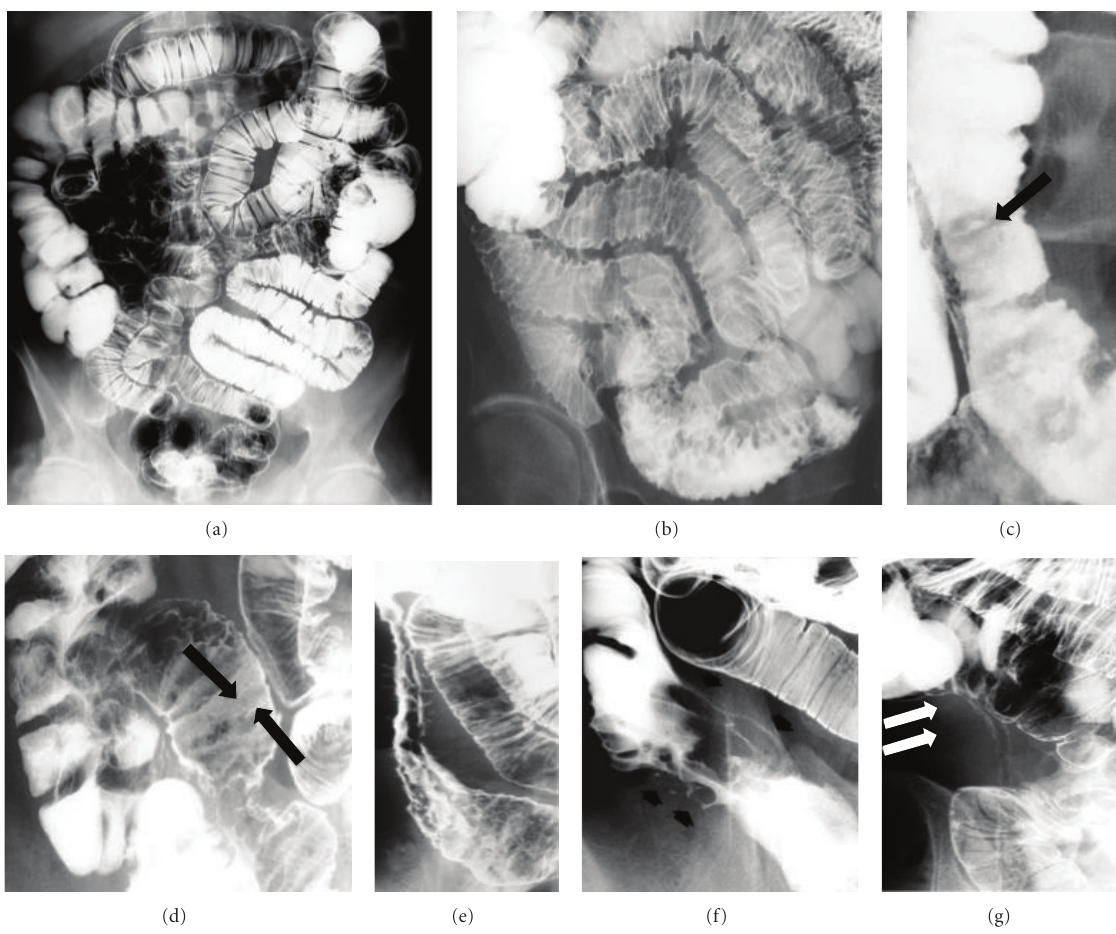
Figure 1: Conventional enteroclysis. (a) Conventional enteroclysis: panoramic view. (b) Mild wall thickening in the ileum. (c) Scattered linear aphthoid lesions (arrow) in a segment of distal small bowel. (d) Mucosal ulcers (arrows). (e) Typical cobblestone-like nodular filling defects and ulceration. (f) Fistula (arrows). (g) Stenotic loop (arrows).